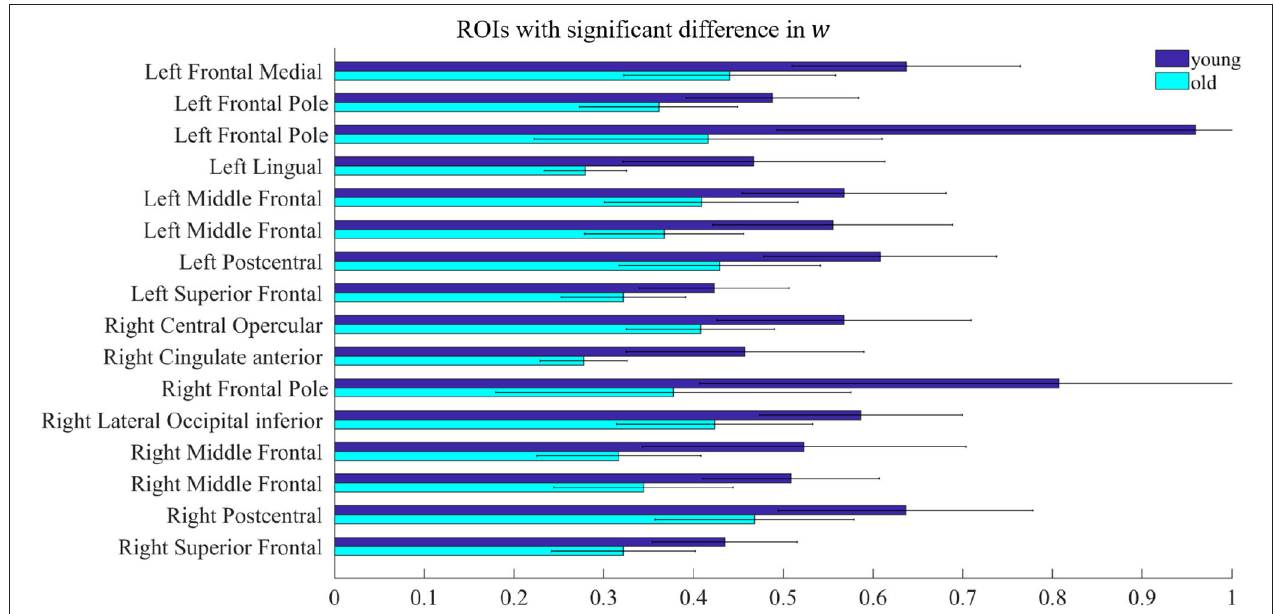
FIGURE 2 | ROIs with significant difference in w . Each pair of bars represents the mean value of the parameter w in the same ROI for the young group (dark blue) and the old group (light blue). The lines on the bars indicate the standard deviation.